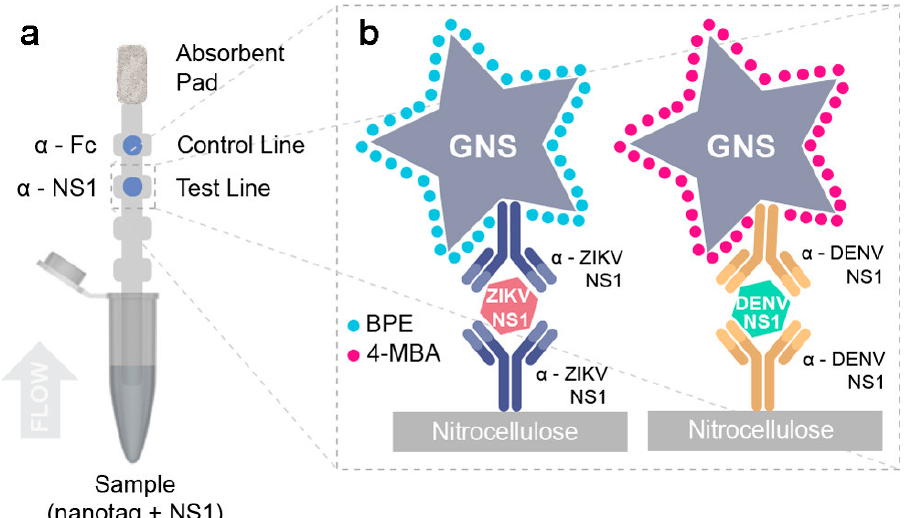
Figure 4. Sandwich immunoassay: ( a ) schematic of a dipstick sandwich immunoassay and ( b ) sandwiches formed by each antibody pair, NS1 and GNS − Ab conjugate, for both ZIKV and DENV NS1 at the test line. Fc, the Fe region of the protein; NS1, nonstructural protein 1; ZIKA, Zika virus; DENV, dengue virus; GNS, gold nanostar. (Reproduced with permission from [89]. Copyright 2017, ACS.)